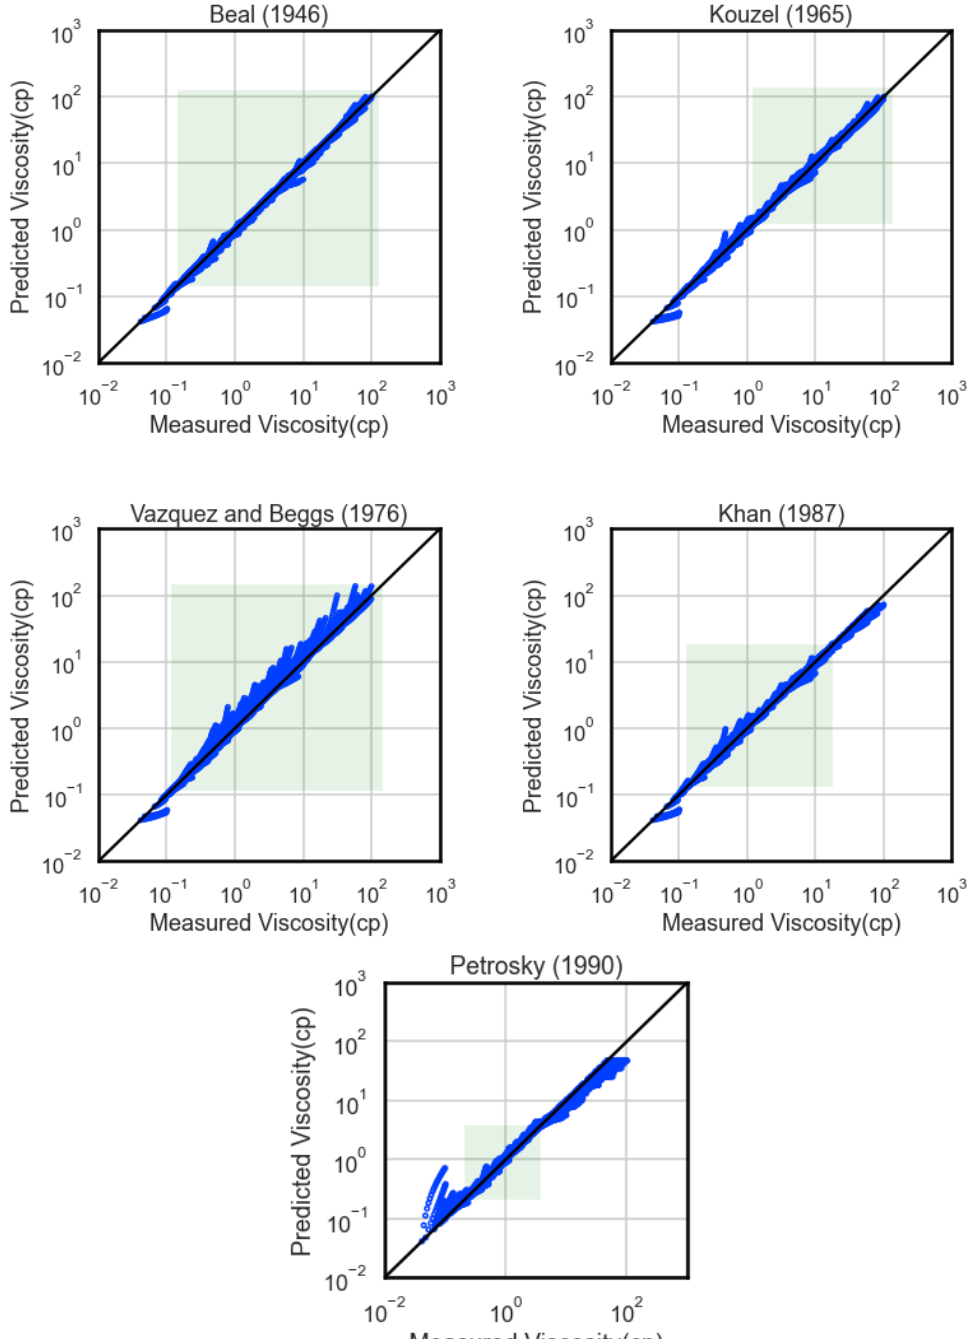
Figure A1. Parity plots of correlations in cluster A 1